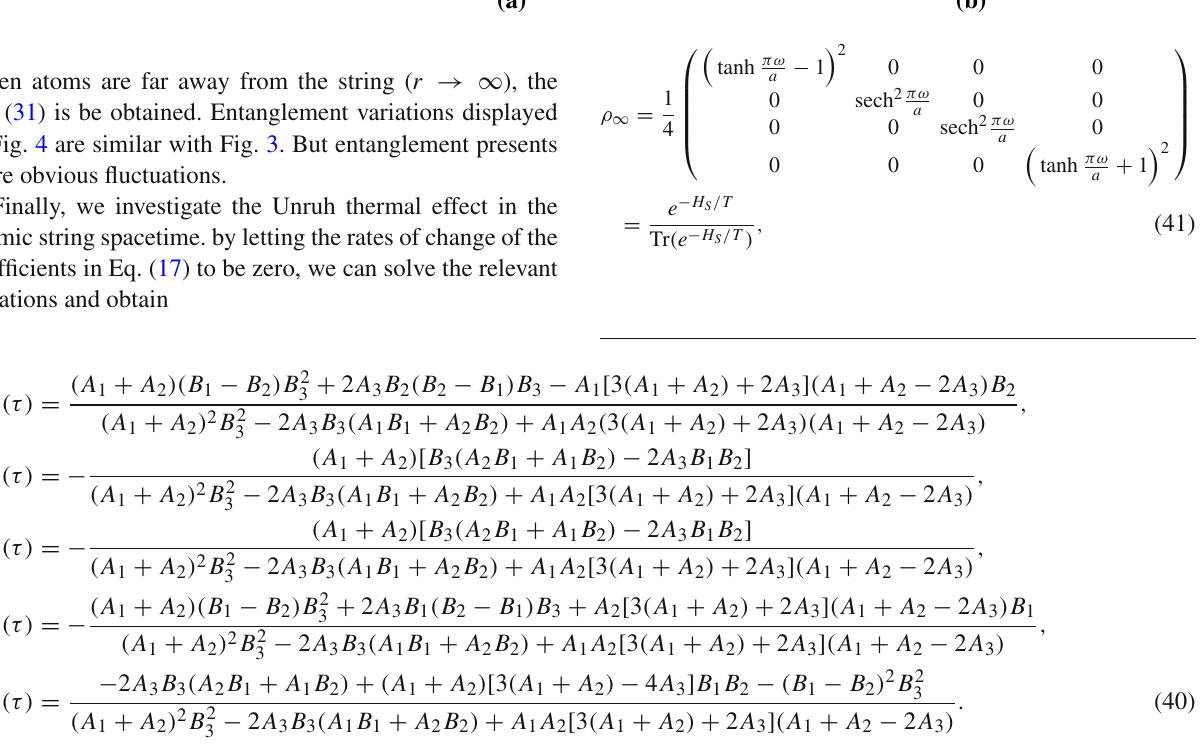
Fig. 4 Entanglement as function of Γ τ with different atom-string distances for initial Werner state with p = 2/3, ν = 3, a /ω = 1 / 2 and ω L = 1 /